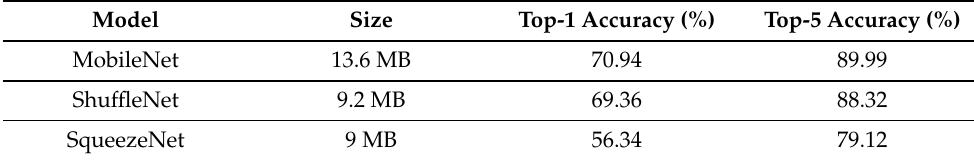
Table 2. Performance of the three